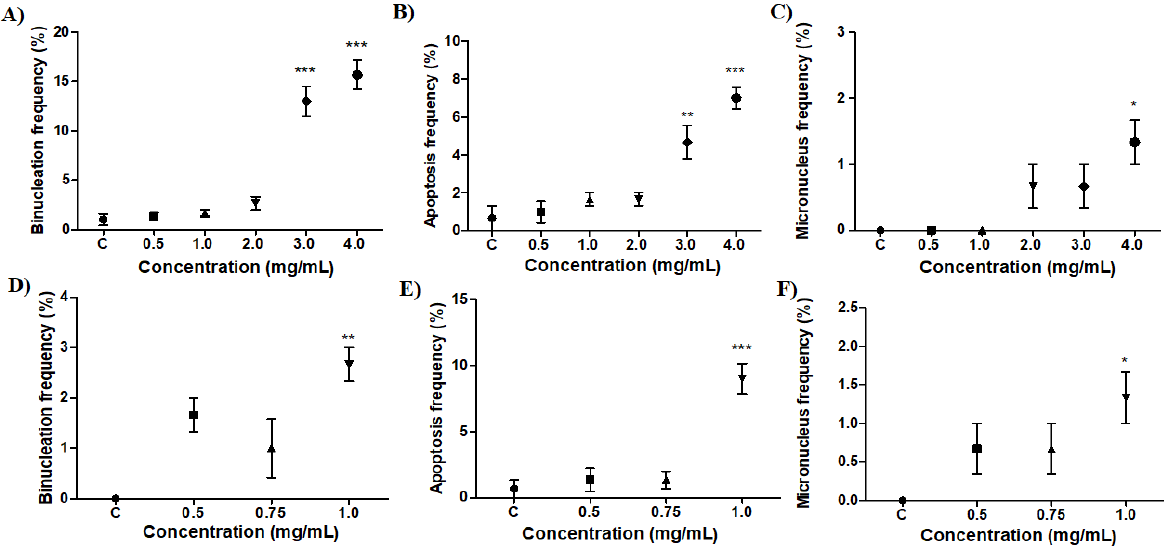
Figure 5. Morphological changes after exposure to different concentrations of saline extract and fraction. Binuclear cells ( A ), apoptosis ( B ) and micronucleus alterations after exposure to saline extract ( C ); binuclear cells ( D ), apoptosis ( E ) and micronucleus alterations after exposure to the fraction ( F ). C: negative control. Dot shapes are only to differentiate concentrations. Each concentration was compared with the negative control: significance * = p < 0.05; ** = p < 0.01 and *** = p <